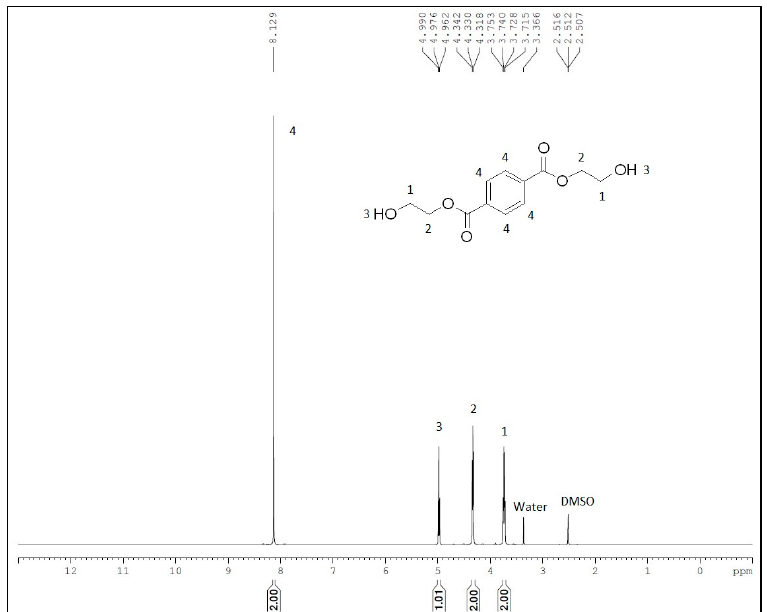
Figure 5. 1 H NMR spectra of recrystallised BHET. Table 3. Optimisation of BHET a .